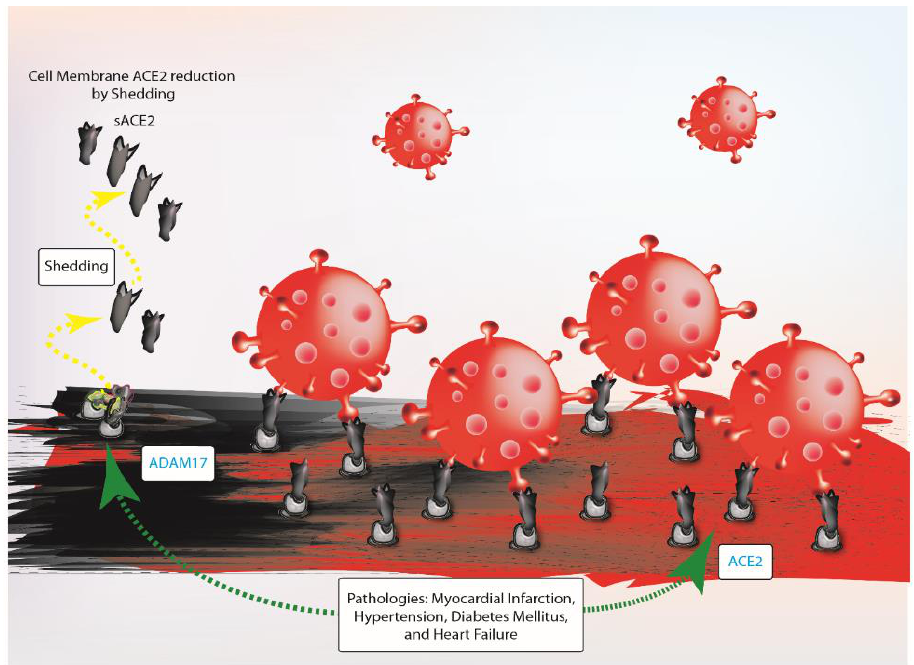
Figure 3. Pathologies such as myocardial infarction, hypertension, diabetes mellitus and heart failure increase the availability of ACE2 suggesting that comorbidities cause high susceptibility towards SARS-CoV-2. ADAM17, ADAM metallopeptidase domain 17; ACE2, angiotensin-converting enzyme 2; sACE2, soluble ACE2.